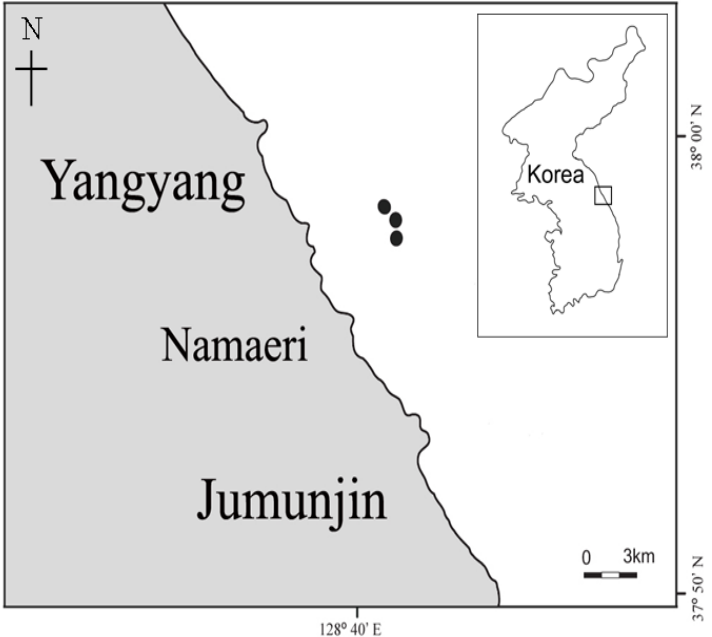
Figure 1. Map showing the location of the set nets in the coastal waters of Yangyang.